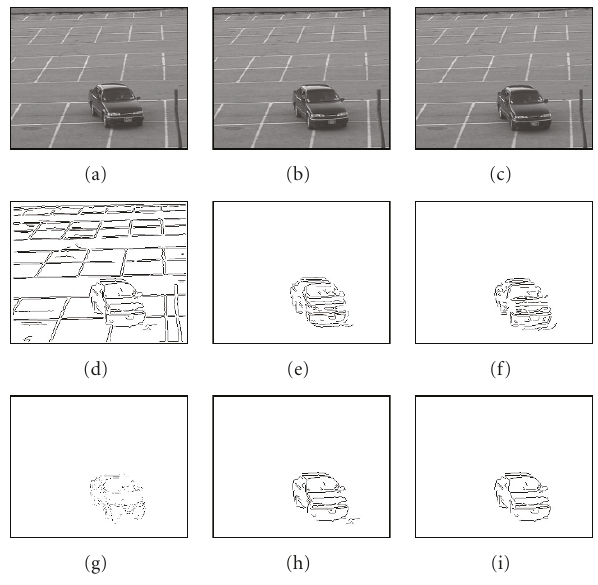
Figure 5: Illustration of the proposed moving edge detection method. (a) I n − 1 ; (b) I n ; (c) I n +1 ; (d) E n ; (e) DE n − 1, n ; (f) DE n , n +1 ; (g) moving edges obtained from pixel-based matching of DE n − 1, n and DE n , n +1 ; (h) coarse moving edge list; (i) moving edges after noise filtering.